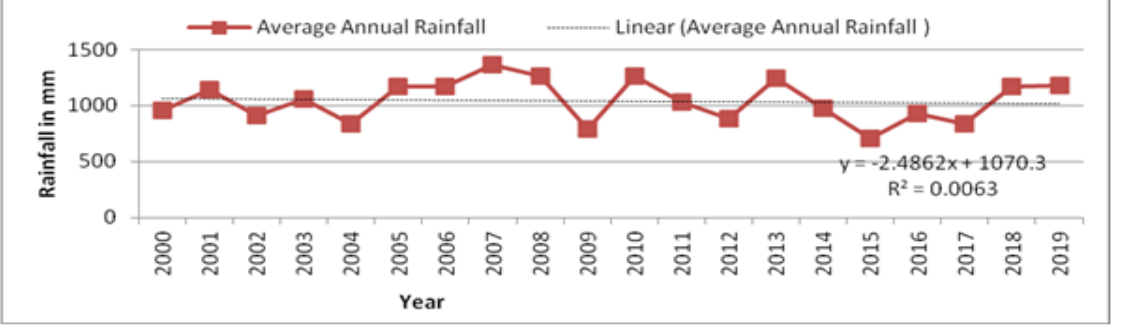
Source: National Meteorology Agency of Ethiopia (Hawassa